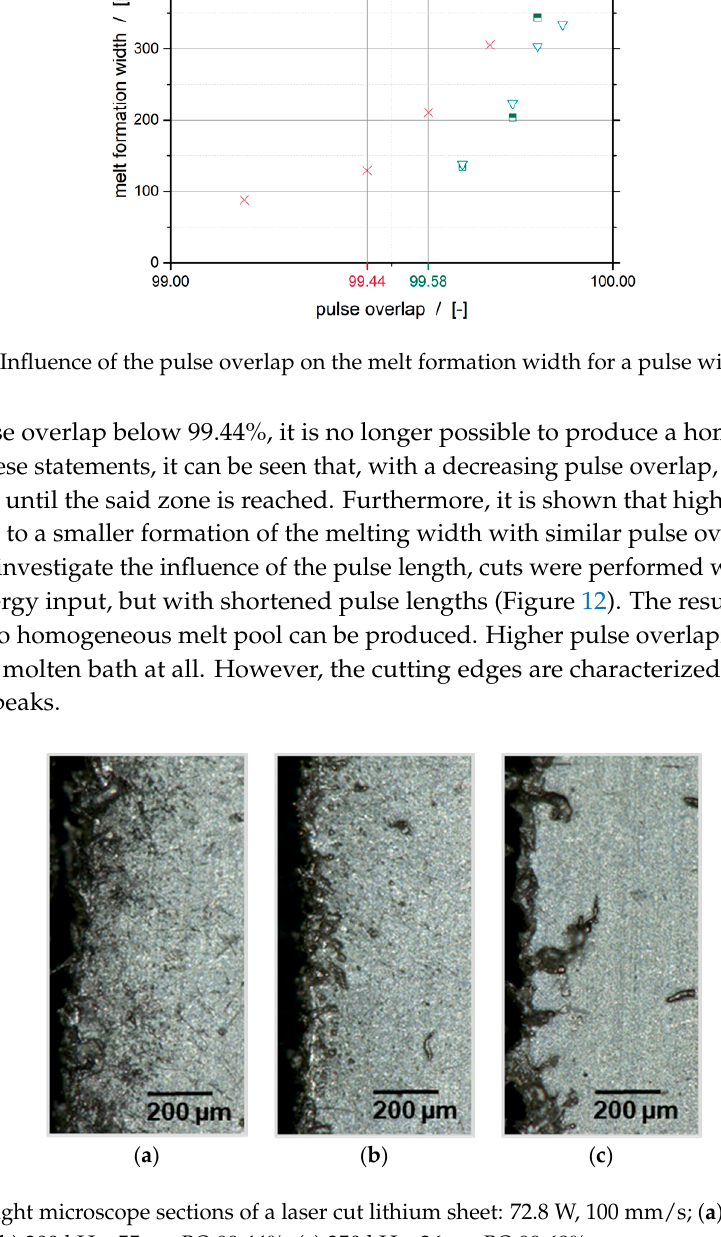
( c ) Figure 13. Light and laser scanning microscope sections of a laser cut lithium sheet: 72.8 W, 490 kHz , 240 ns, dew point − 15 °C; ( a ) 50 mm/s, PO 99.89%; ( b ) 100 mm/s, PO 99.77%; ( c ) 150 mm/s, PO 99.66%. With the same laser and system parameters, at a lower dew point of − 30 °C, these black deposits cannot be identified by light microscope images (Figure 14). An influence of the laser system parameters on the degree of contamination therefore cannot initially be determined.